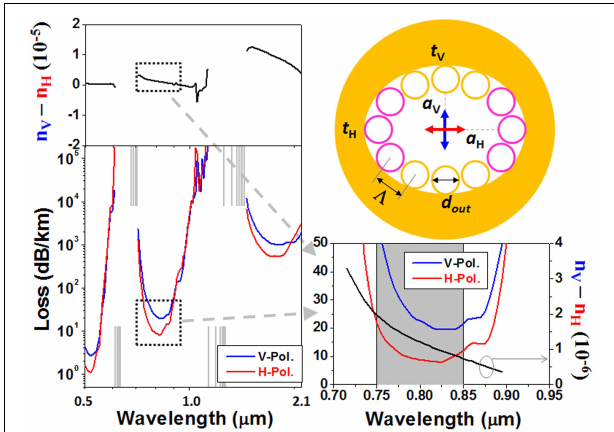
FIGURE 12 | Simulated birefringence and PDL of a realistic HC-ARF. 13 µ m, a H 19 µ m, d out 10.2 µ m, t V a V 0 . 67 µ m (for the yellow = = = = capillaries), and t H 0 . 6 µ m (for the pink capillaries). All the center-to-center = distances between adjacent capillaries are 3 10 . 96 µ m > d out =